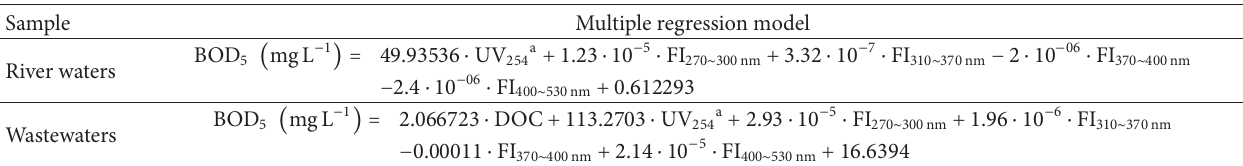
T 4: Multiple linear regression models for predicting BODs of river waters and